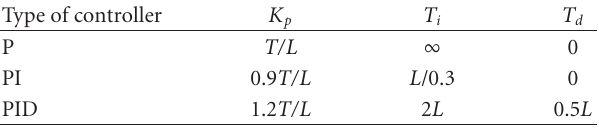
Table 1: Ziegler-Nichols tuning rules. Type of controller